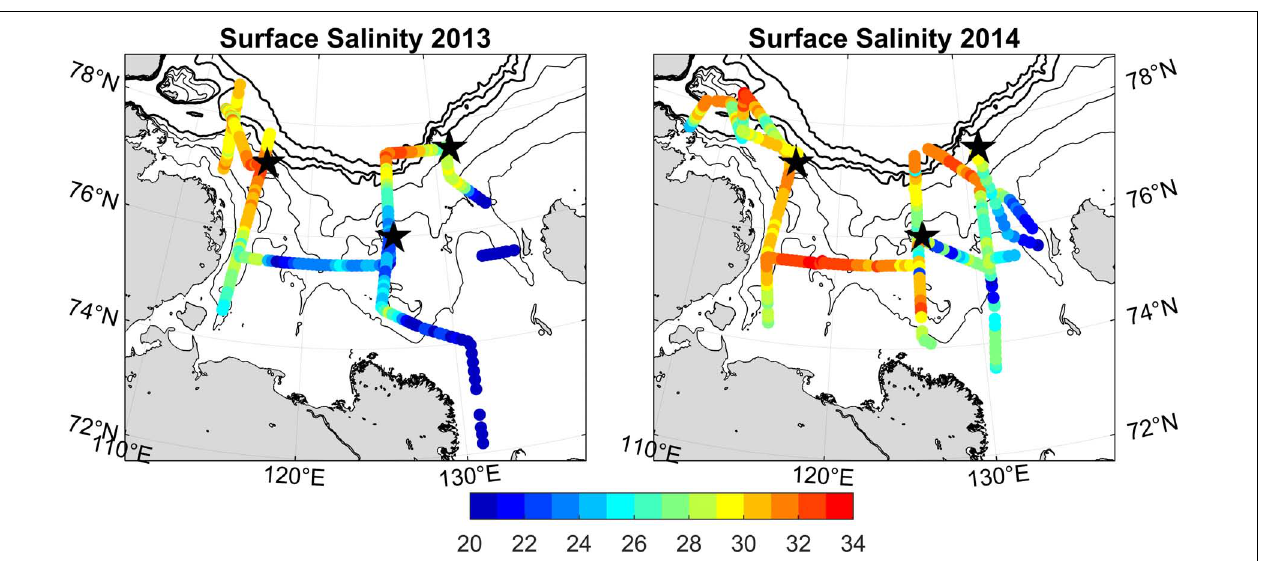
Sea. In 2014, minimum surface salinities were ∼ 20 and limited to a small region in the east, while the rest of the shelf was much more saline and strongly contrasted with the conditions observed